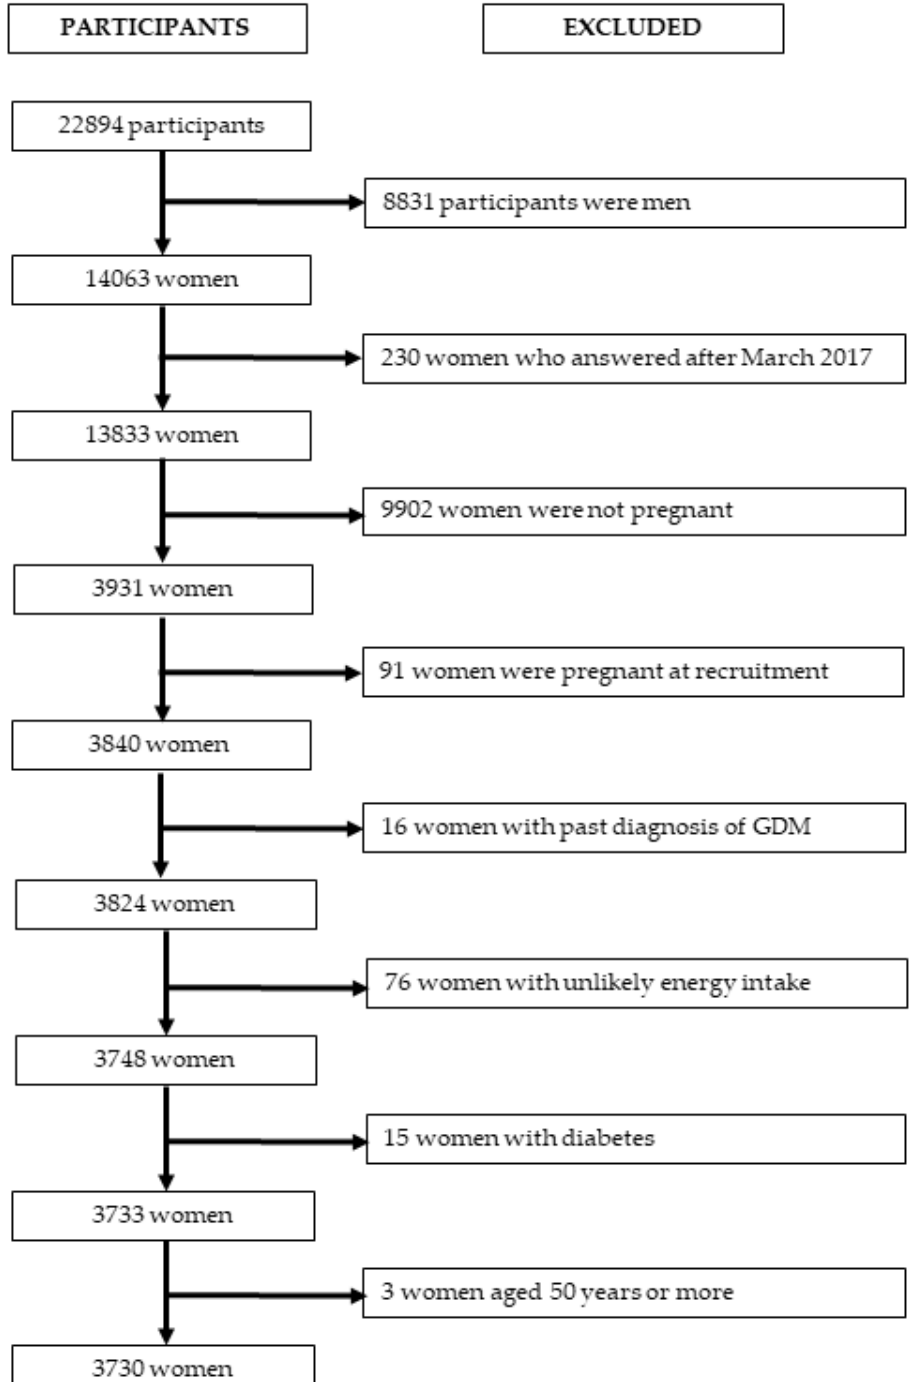
Figure 1. Flow chart showing the selection process of participants in the SUN project to be included in the present analysis. Energy intake below the first percentile or above the 99th percentile was considered unlikely. Abbreviation: GDM, gestational diabetes mellitus.